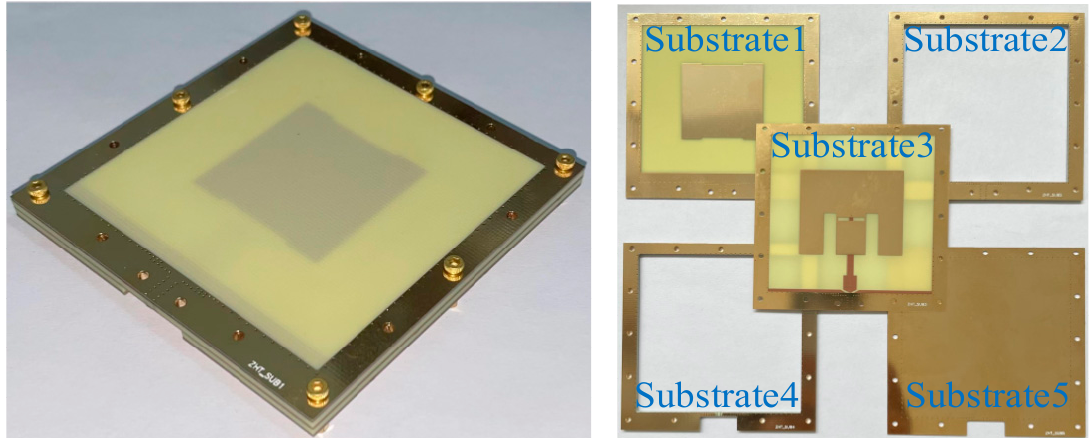
Figure 10. Prototype of the proposed antenna.